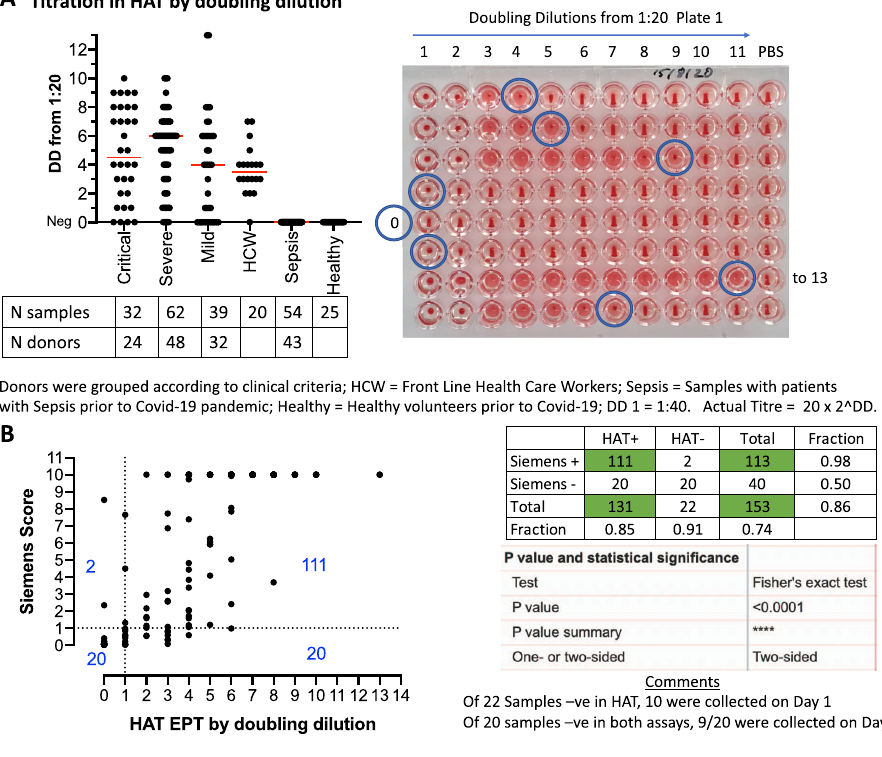
Fig. 5 Titration of the set of 232 samples in the HAT. A The collection included 32 samples from 24 critical patients, 62 samples from 48 severe, 39 samples from 32 mild, 20 single samples from healthcare workers (HCW), 54 samples from 43 patients with unrelated sepsis in the pre COVID-19 era, and 25 samples from healthy unexposed controls. Median is indicated by a red line. DD doubling dilutions. B Comparison to Siemens result (anti-RBD) with HAT titre by doubling dilution for 153 samples from critical, severe, mild, and HCW SARS-CoV-2 PCR positive donors. Source data are provided as a Source Data fi